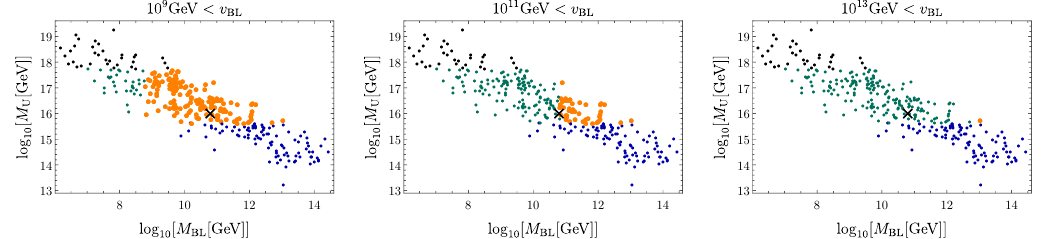
Figure 2 . Intermediate and uni(cid:12)cation scale for randomised scalar threshold corrections in Model 1. Only the large orange points are not excluded by our constraints. Points in blue are excluded by proton decay limits, points in black are excluded by the limits from black hole superradiance constraints. Points in green are allowed by black hole superradiance and proton decay, but forbidden by the chosen range of B-L breaking. The black cross indicates the minimal threshold case, i.e. the case when all scalar masses are degenerate and at the corresponding uni(cid:12)cation scales for which the running of the gauge couplings is illustrated in (cid:12)gure 1. We have performed the scan for 400 sets of initial conditions, 310 of which yielded uni(cid:12)cation of the gauge couplings. the (cid:12)gures of the rest of the section, constraints imposed by the B-L scale will be shown in